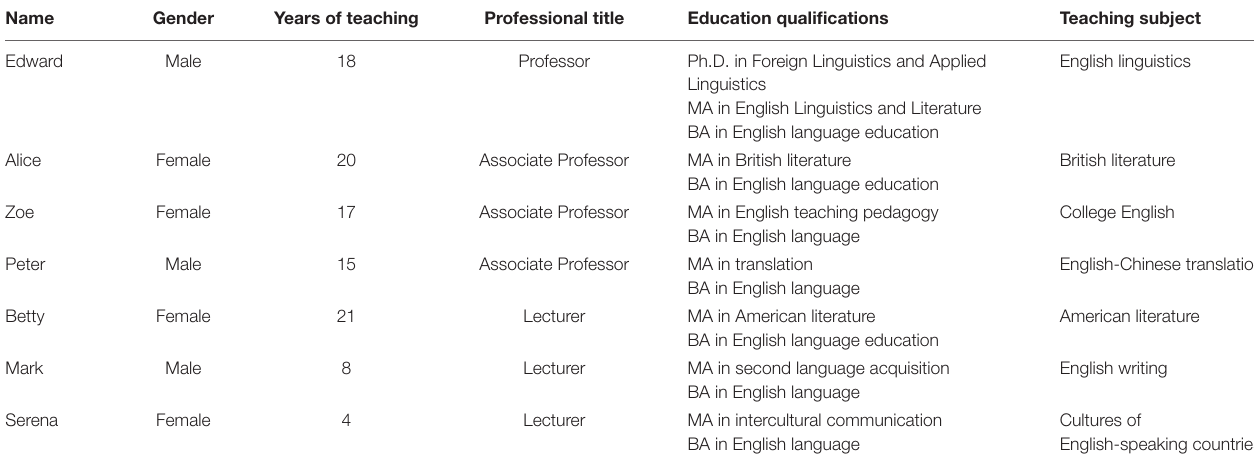
TABLE 2 | Background information of the